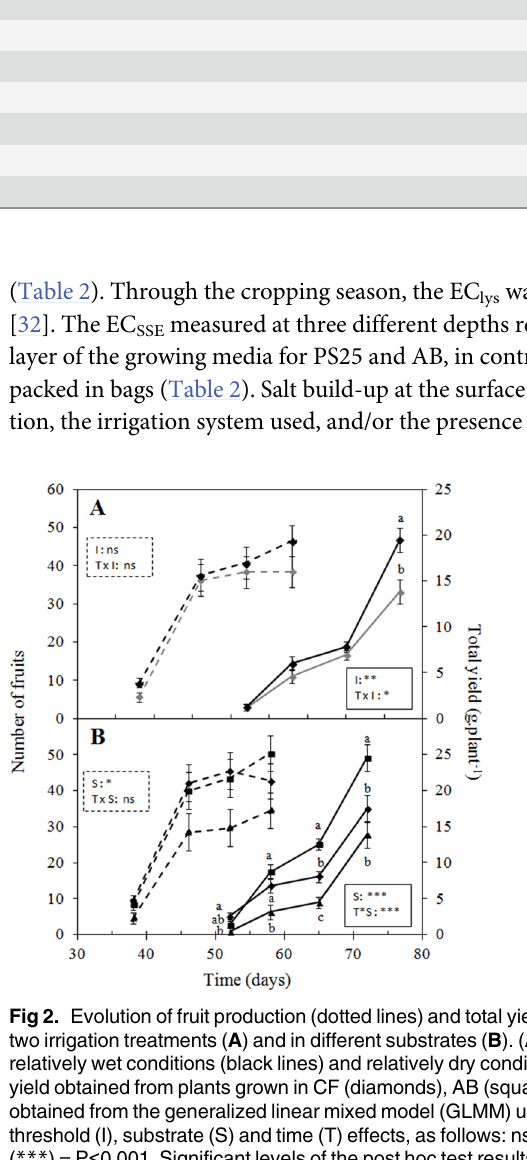
Fig 2. Evolution of fruit production (dotted lines) and total yield (plain lines) of strawberry plants grown under two irrigation treatments ( A ) and in different substrates ( B ). ( A ) Variation in the two parameters under relatively wet conditions (black lines) and relatively dry conditions (grey lines). ( B ) Number of fruits and total yield obtained from plants grown in CF (diamonds), AB (squares) and PS25 (triangles). The P-values obtained from the generalized linear mixed model (GLMM) used to fit the data are reported for the irrigation threshold (I), substrate (S) and time (T) effects, as follows: ns: no significant; ( * ) = P < 0.05; ( ** ) = P < 0.01; ( *** ) = P < 0.001. Significant levels of the post hoc test results are indicated by letters. Each point represents the mean (n = 3) with